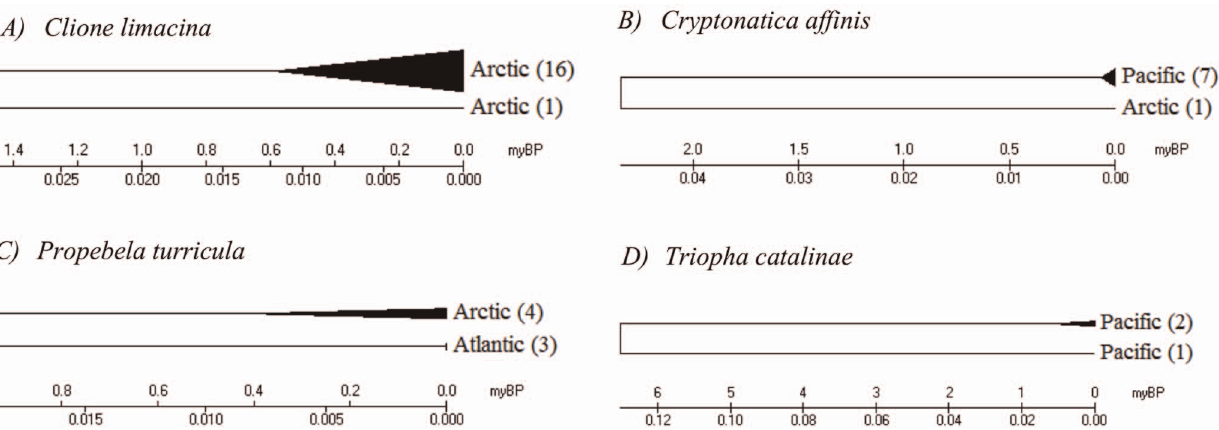
Figure 6. Deep divergences at COI within species of gastropod. Neighbour-joining trees (K2P) with locality information for four gastropod species showing more than 2% sequence divergence at COI. Triangles on the NJ tree represent compressed clades, with sample size provided in brackets.